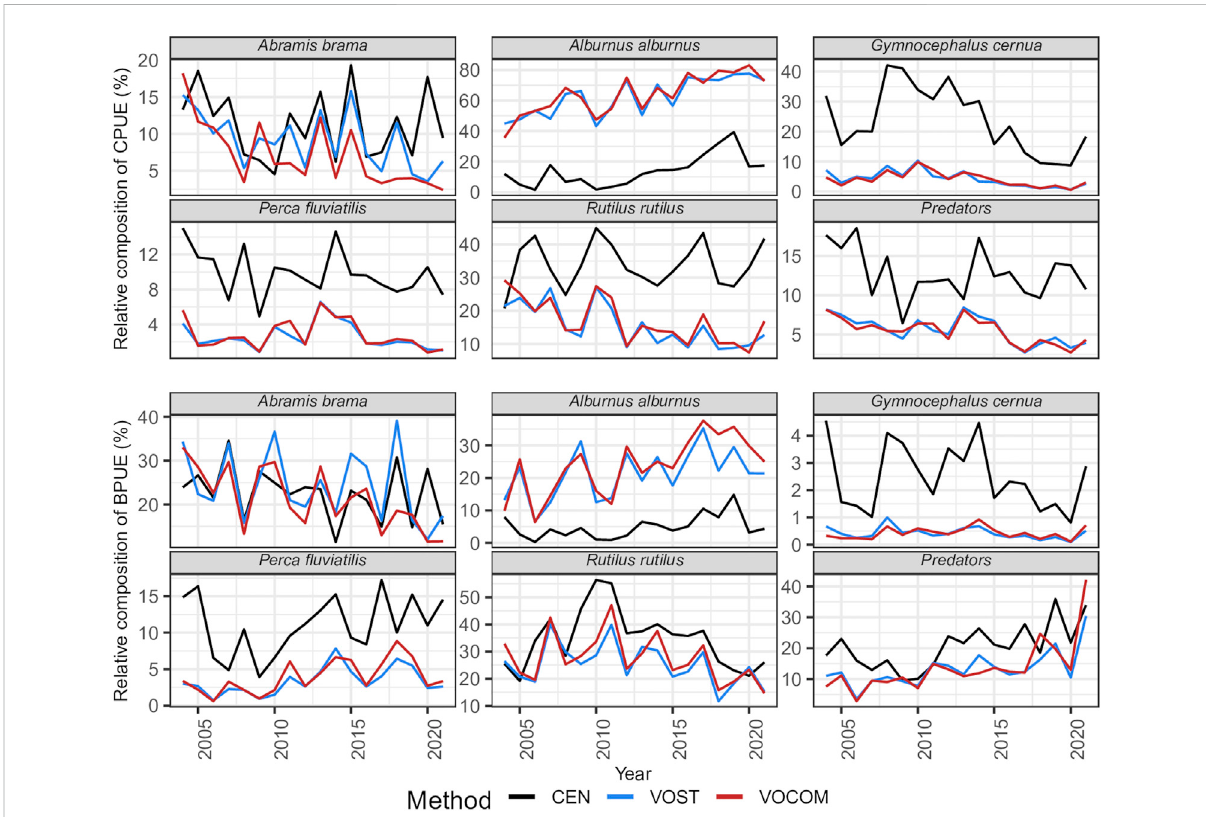
FIGURE 4 Relative composition of fi ve predominant fi sh species and predators to the estimated total VPUEs of the time series obtained by three approaches (CEN, VOST and VOCOM) in Ř ímov